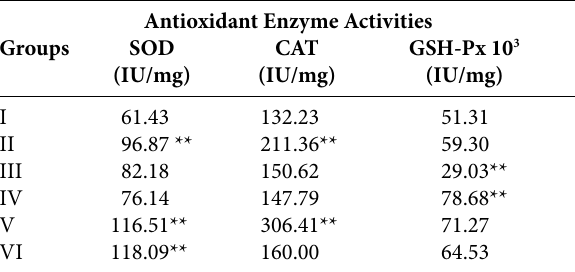
Figure 1. Effect of chlorpyrifos and deltamethrin on the wheat plant lipid peroxidation as measured by MDA value. CP and DM were administered in different doses. Group I (control group), group II (1 mg kg –1 CP group), group III (15 mg kg –1 CP group), group IV (5 mg kg –1 DM group), group V (35 mg kg –1 DM group), group VI (combination group of 1 mg kg –1 CP and 5 mg kg –1 DM). Values are represented as means ** significantly different from control at P < 0.001. Table 1. Effect of CP and DM on the SOD, CAT and GSH-Px activ- ities of wheat plant. Values are represented as means S.D. of eight plants in each group. ** Significantly different from control at P < 0.001.